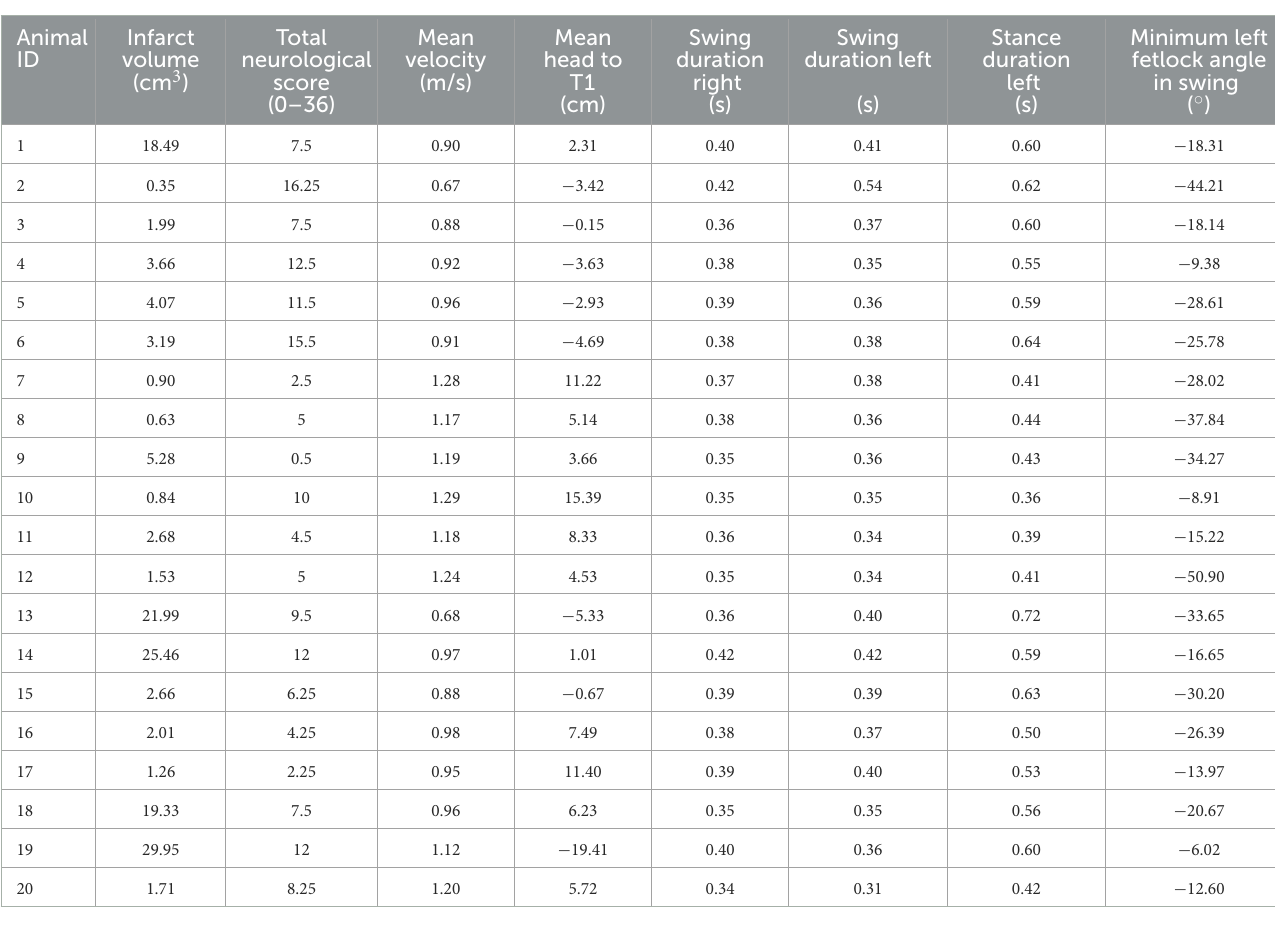
TABLE 2 Variables included for principal component analysis.